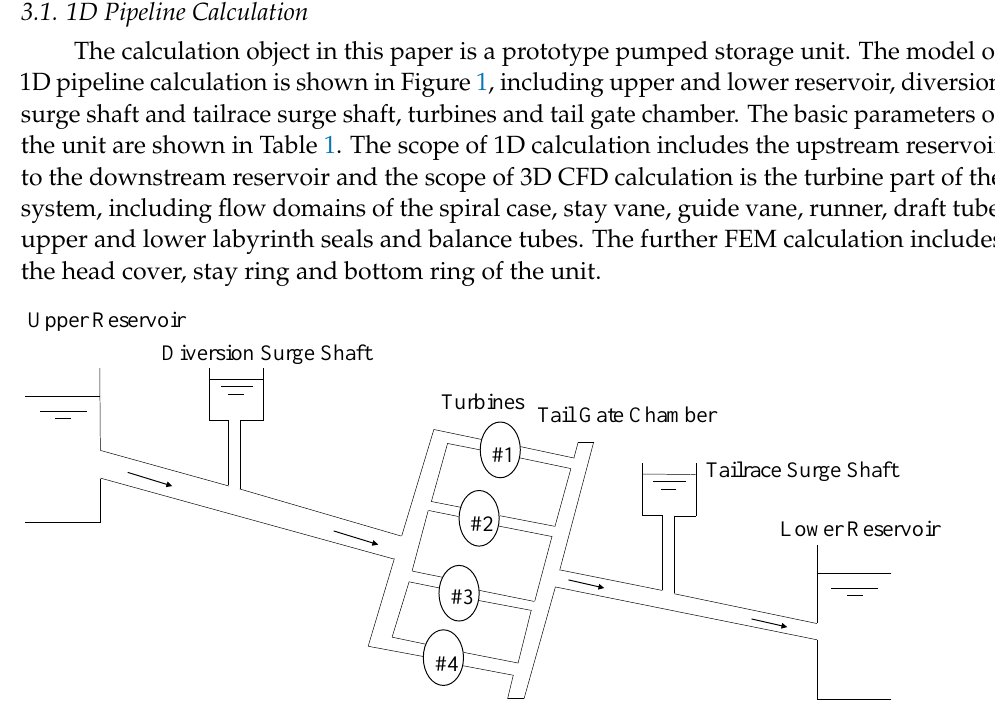
Figure 1. The 1D pipeline calculation model with 4 PT units (#1 to #4). Table 1. Parameters of the